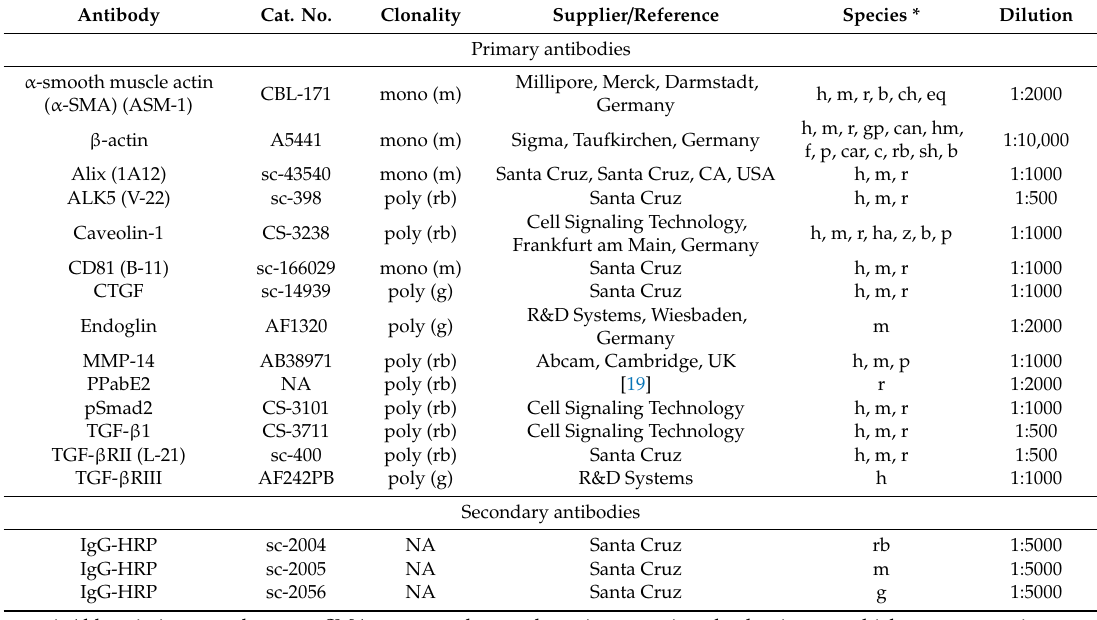
Table 1. Antibodies used in this study in alphabetical order. Antibody Cat. No. Clonality Supplier / Reference Species * Primary